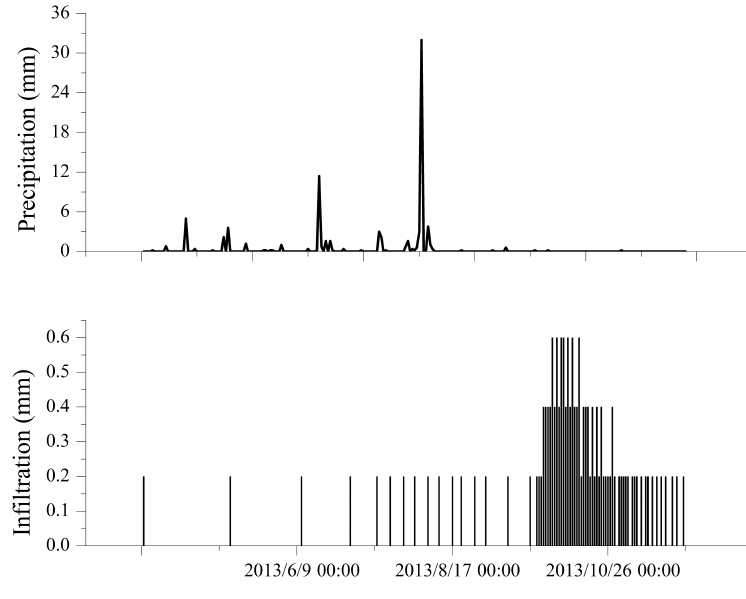
Figure 3. Precipitation and DSR patterns in 2013.